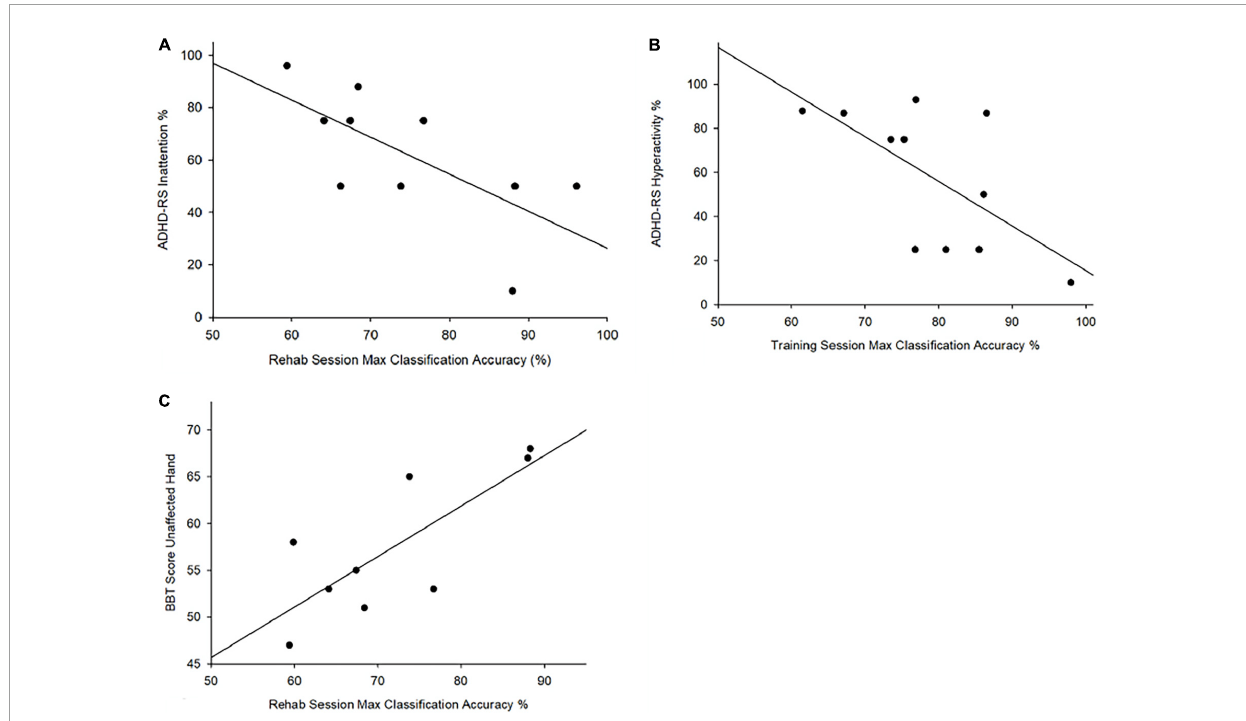
FIGURE4 Attention and box and block test scores vs. maximum classification accuracy. correlation between (A) ADHD-RS Inattention% and maximum classification accuracy achieved rehabilitation ( r = –0.690, p = 0.027); (B) ADHD-RS hyperactivity% and maxim classification accuracy achieved during training ( r = –0.646, p = 0.032); (C) Correlation between BBT scores for the unaffected hand and the highest achieved classification accuracy during rehabilitation ( r = 0.78, p =